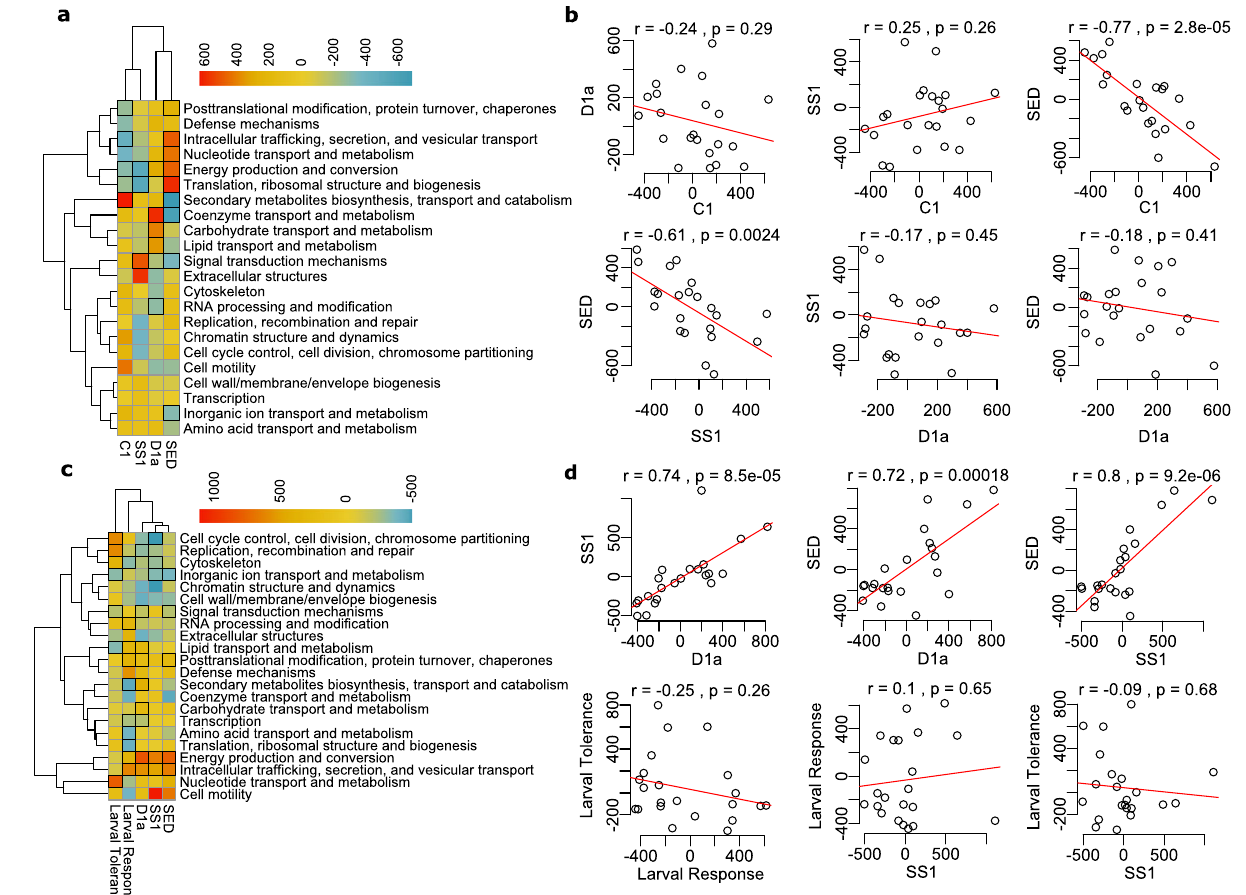
Fig. 4 | Functional similarities in juvenile responses to hosting different sym- bionts and exposed to heat stress. Hierarchical clustering analysis of KOG enrichmentsinjuvenileshostingdifferentsymbiosesatambientconditions( a )and host responses to heatin juveniles hosting different symbioses ( c ).Correlations of KOG delta rank values for each comparison under ambient conditions ( b ) and